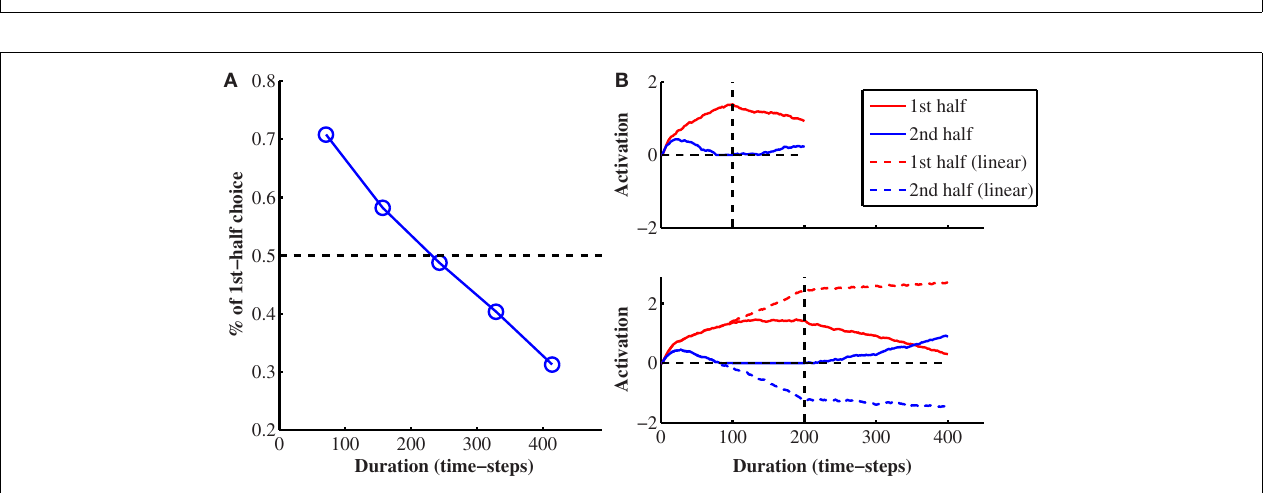
short (top) and long (bottom). Red denotes the alternative supported in the first half of the trial, while blue denotes the alternative supported in the second half. In the bottom panel, we also plotted out the simulation results using the linear LCA (dashed